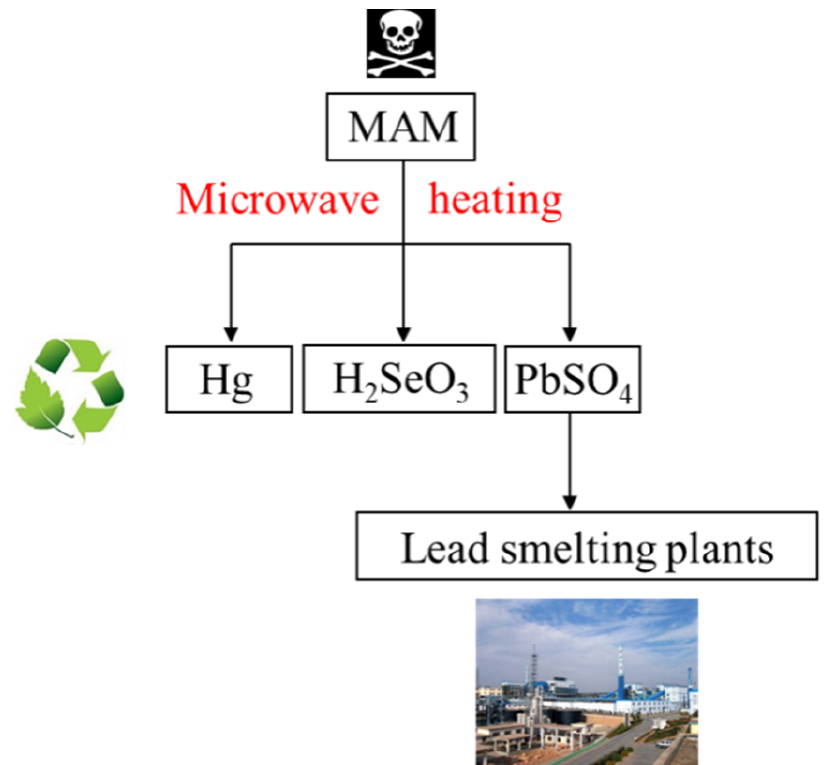
Figure 10. Hazard-free treatment of MAM and efficient recovery of metal by microwave. Table 2. Effect of different treatment methods on mercury recovery of MAM.